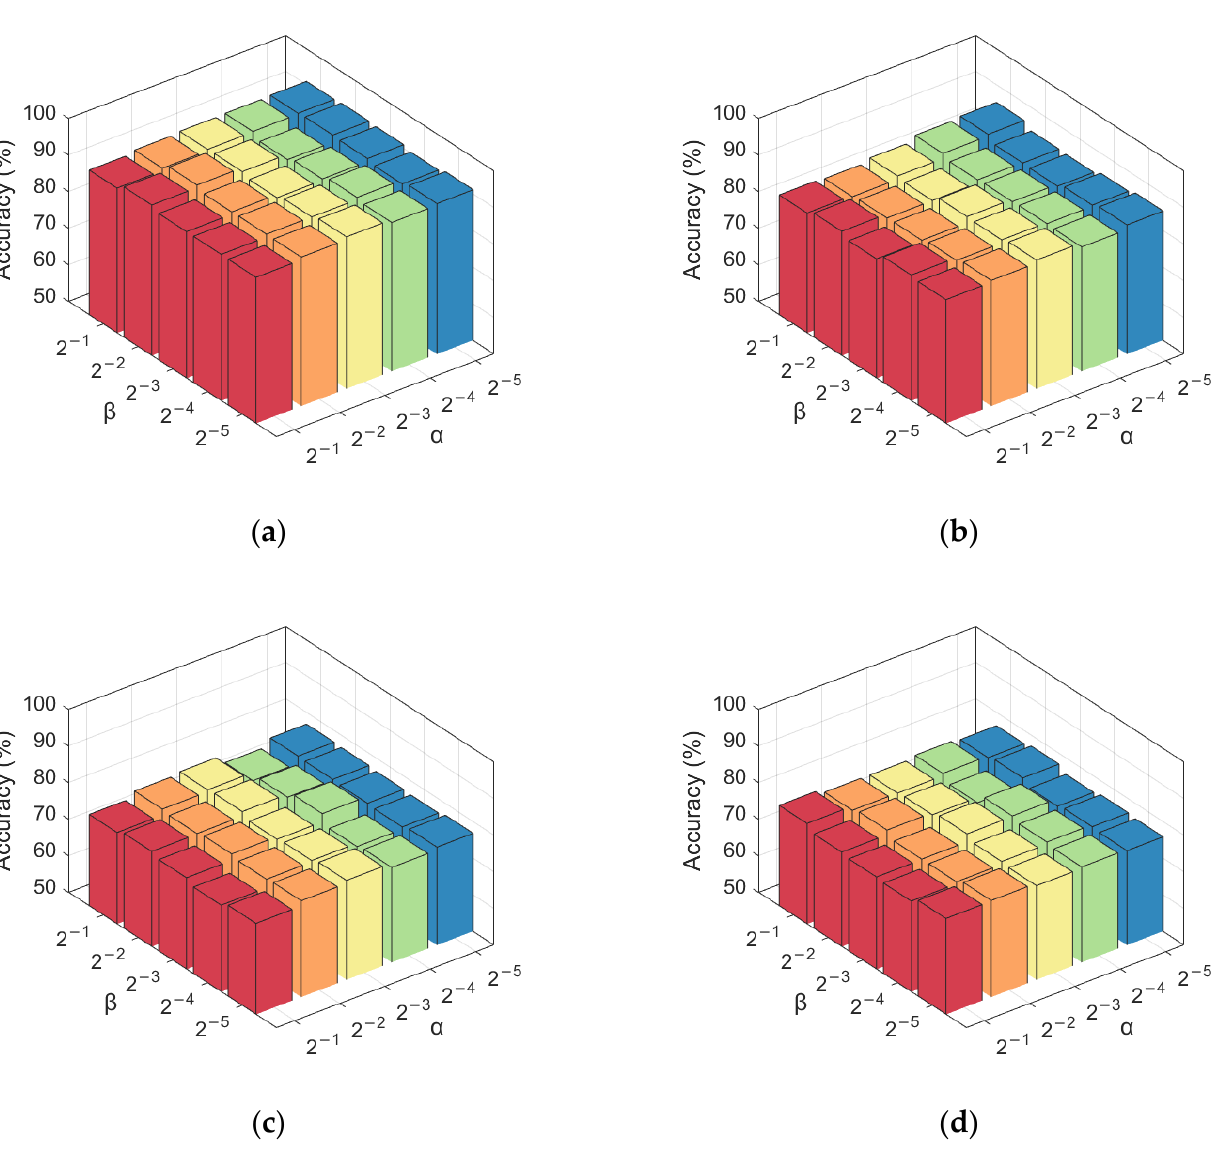
Figure 4. Influence of regularization parameters on classification accuracy. ( a ) NC vs. AD, ( b ) NC vs. LMCI, ( c ) NC vs. EMCI, ( d ) EMCI vs. LMCI.